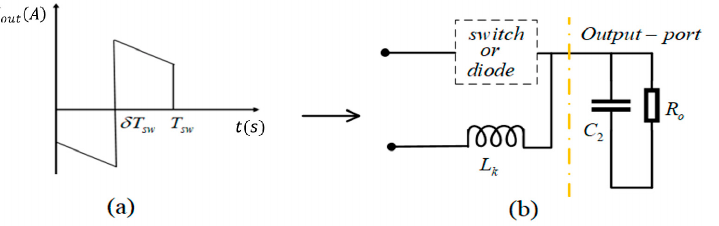
Figure 5. ( a ) Pulsed output-port current with both positive and negative components and ( b ) circuit diagram.